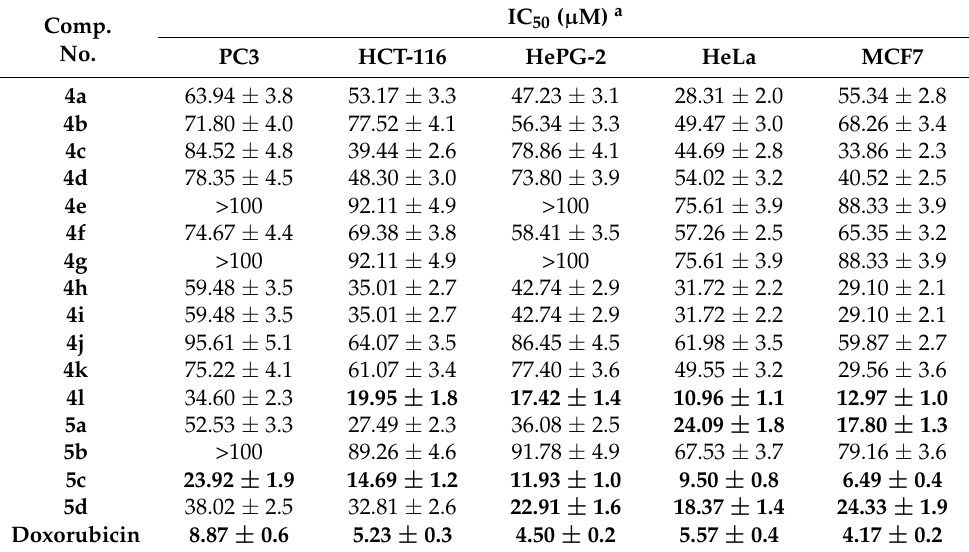
Table 3. In vitro anti-proliferative activity of the tested compounds 4a – l , 5a – d, and Doxorubicin expressed as IC 50 values against prostate cancer (PC3), human colorectal cancer (HCT-116), human hepatocellular carcinoma (HePG-2), human epithelioid carcinoma (HeLa), and MCF7 human cancer cell line.